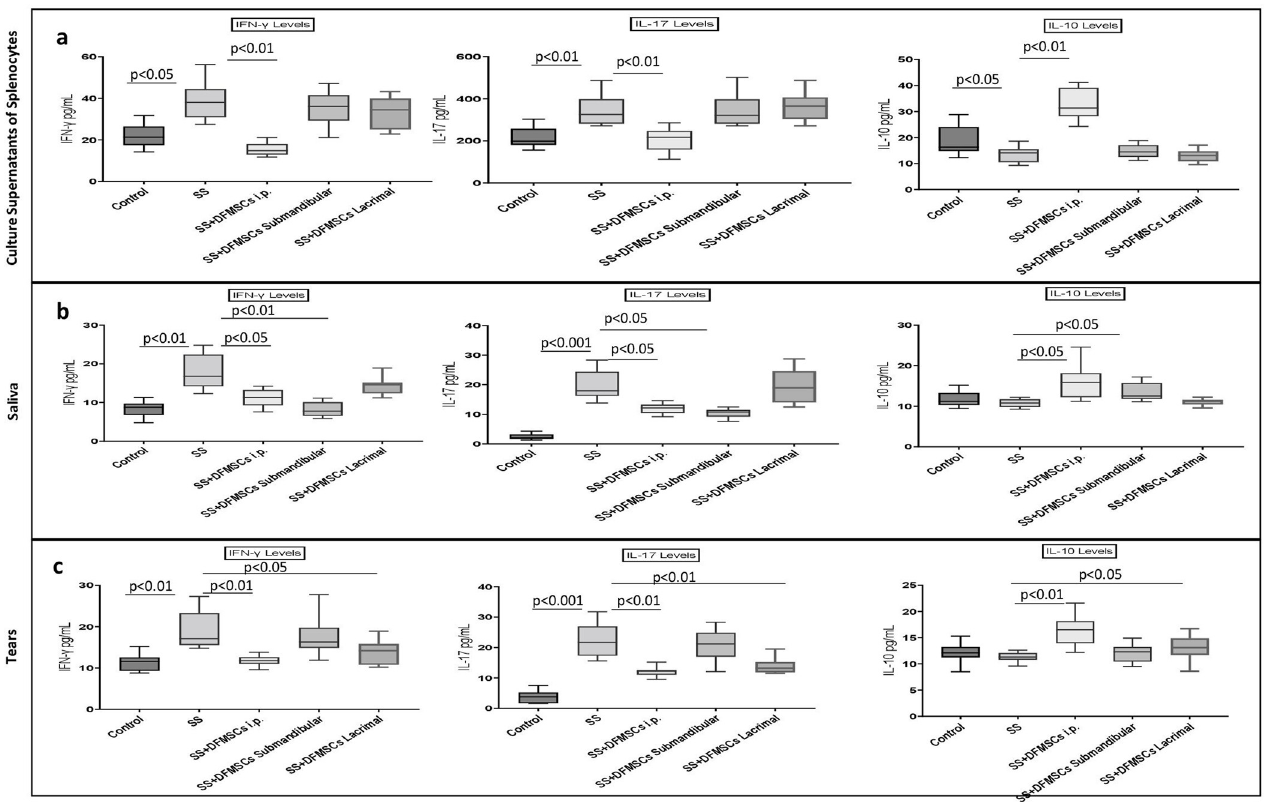
Fig 4. The secreted cytokine levels in the culture supernatant of splenocytes, saliva, and tears. (a) The cytokine levels in the culture supernatants of splenocytes. Intraperitoneal injection of DFMSCs significantly increased IL-10 levels in Group 3a (p < 0.01), and significantly decreased the secreted IFN- γ and IL-17 levels compared to Group 2 (p < 0.01 and p < 0.01, respectively). Submandibular and lacrimal injections of DFMSCs did not significantly change the secreted IFN- γ (p > 0.05 and p > 0.05, respectively), IL-17 (p > 0.05 and p > 0.05, respectively), and IL-10 levels when compared with Group 2 (p > 0.05 and p > 0.05, respectively). (b) The cytokine levels in saliva. Intraperitoneal injection of DFMSCs significantly increased IL-10 levels in Group 3a (p < 0.05), and significantly decreased the secreted IFN- γ and IL-17 levels compared to Group 2 (p < 0.05 and p < 0.05, respectively). Submandibular injection of DFMSCs significantly decreased the secreted IFN- γ and IL-17 levels in the saliva compared to Group 2 (p < 0.01 and p < 0.05, respectively). Submandibular injection of DFMSCs significantly increased IL-10 levels in the saliva compared to Group 2 (p < 0.05). (c) The cytokine levels in tears. Intraperitoneal injection of DFMSCs significantly increased IL-10 levels in Group 3a (p < 0.05), and significantly decreased the secreted IFN- γ and IL-17 levels compared to Group 2 (p < 0.01 and p < 0.01, respectively). Lacrimal injection of DFMSCs significantly decreased the secreted IFN- γ and IL-17 levels in the tears compared to Group 2 (p < 0.05 and p < 0.01, respectively). Lacrimal injection of DFMSCs significantly increased IL-10 levels in the saliva compared to Group 2 (p <